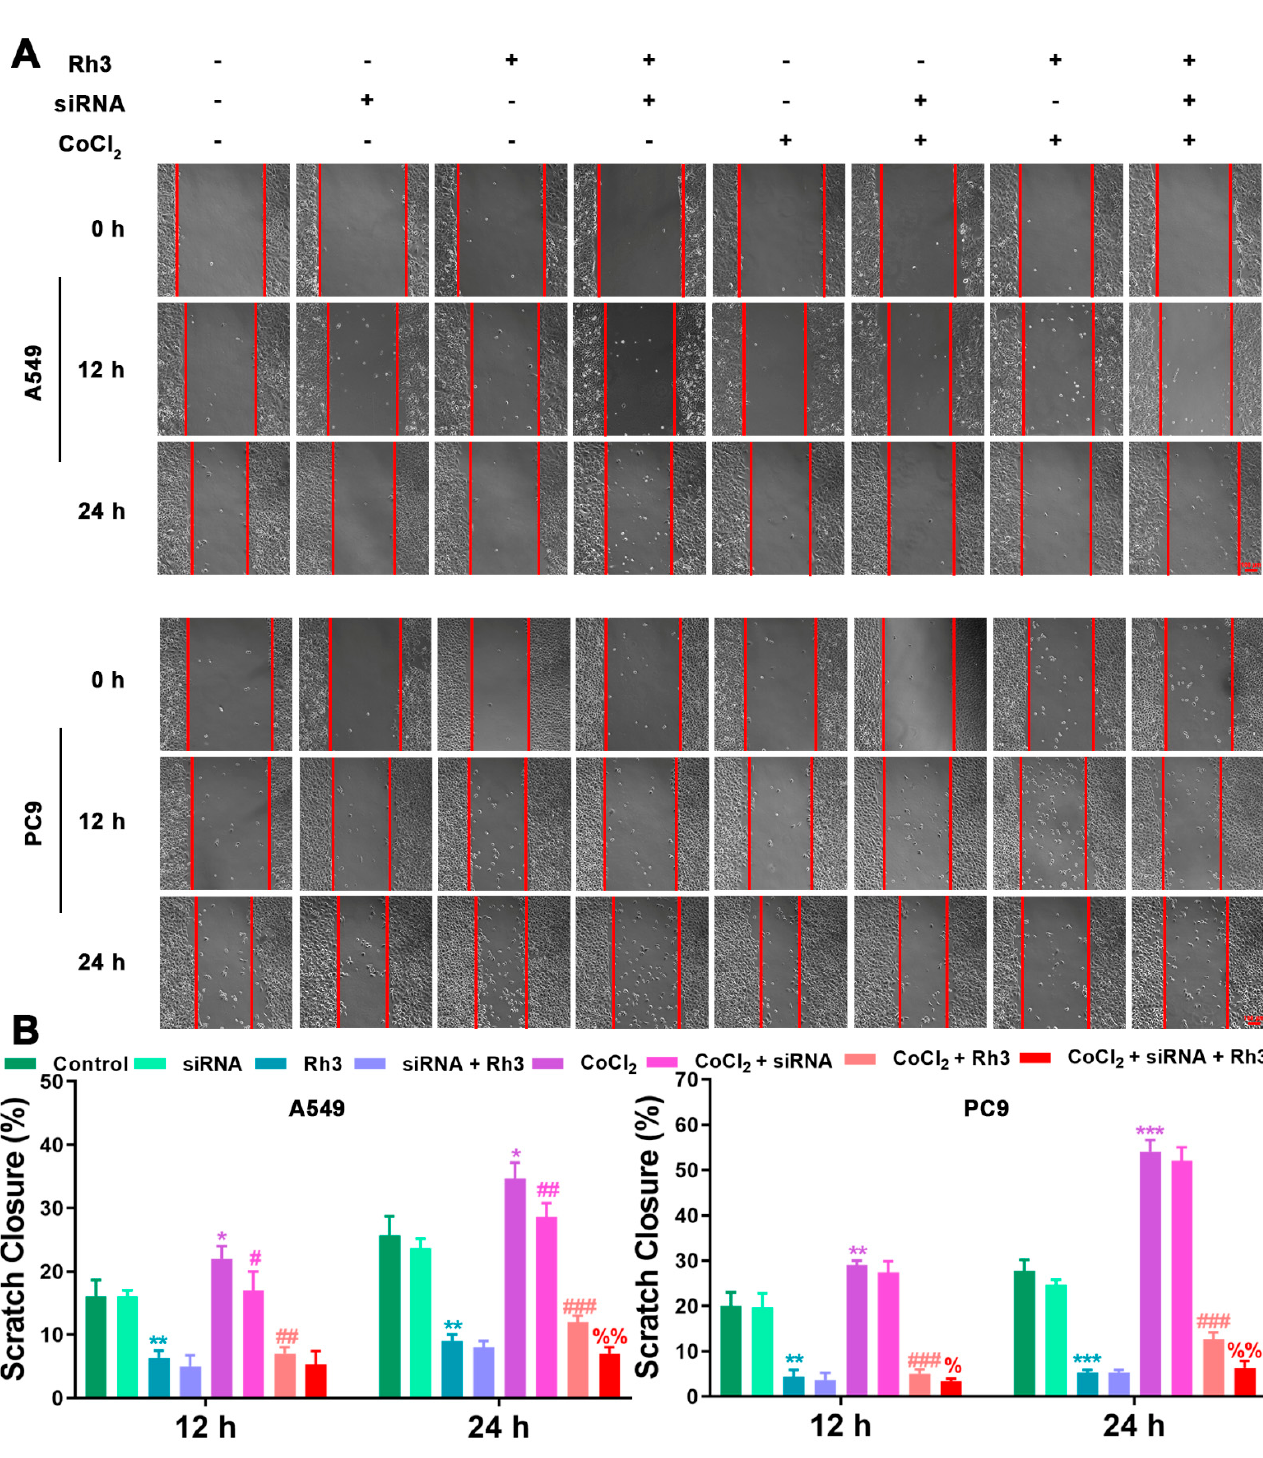
Figure 8. ERK-siRNA augments the inhibitory action of Rh3 in A549 and PC9 cells with respect to metastatic ability. ( A ) A549 and PC9 cells treated with 40 μ M Rh3, ERK-siRNA, and 100 μ M CoCl 2 for the wound-healing assay. ( B ) The wound closures for A549 and PC9 cells at 12 h and 24 h are represented using the histogram. * p < 0.05, ** p < 0.01, *** p < 0.001 compared with the control group; # p < 0.05, ## p < 0.01, ### p < 0.001 compared with the CoCl 2 group; % p < 0.05, %% p < 0.01 compared with the CoCl 2 + Rh3 group.